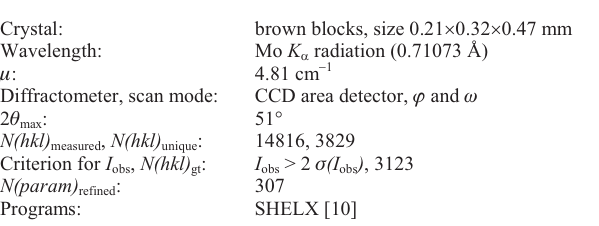
Table 1. Data collection and handling.